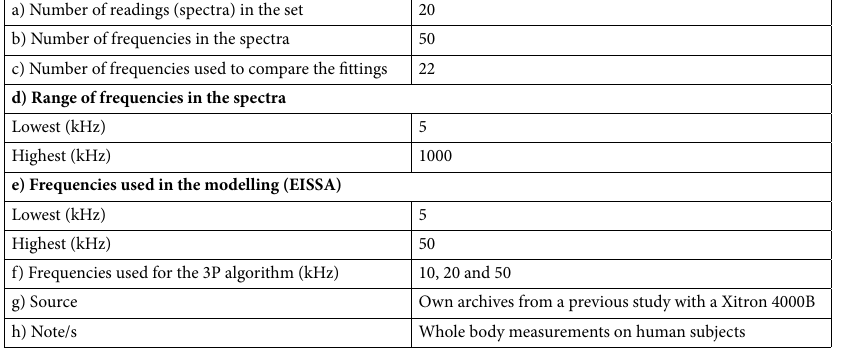
Table 1. Information about subset 0 of data used in this